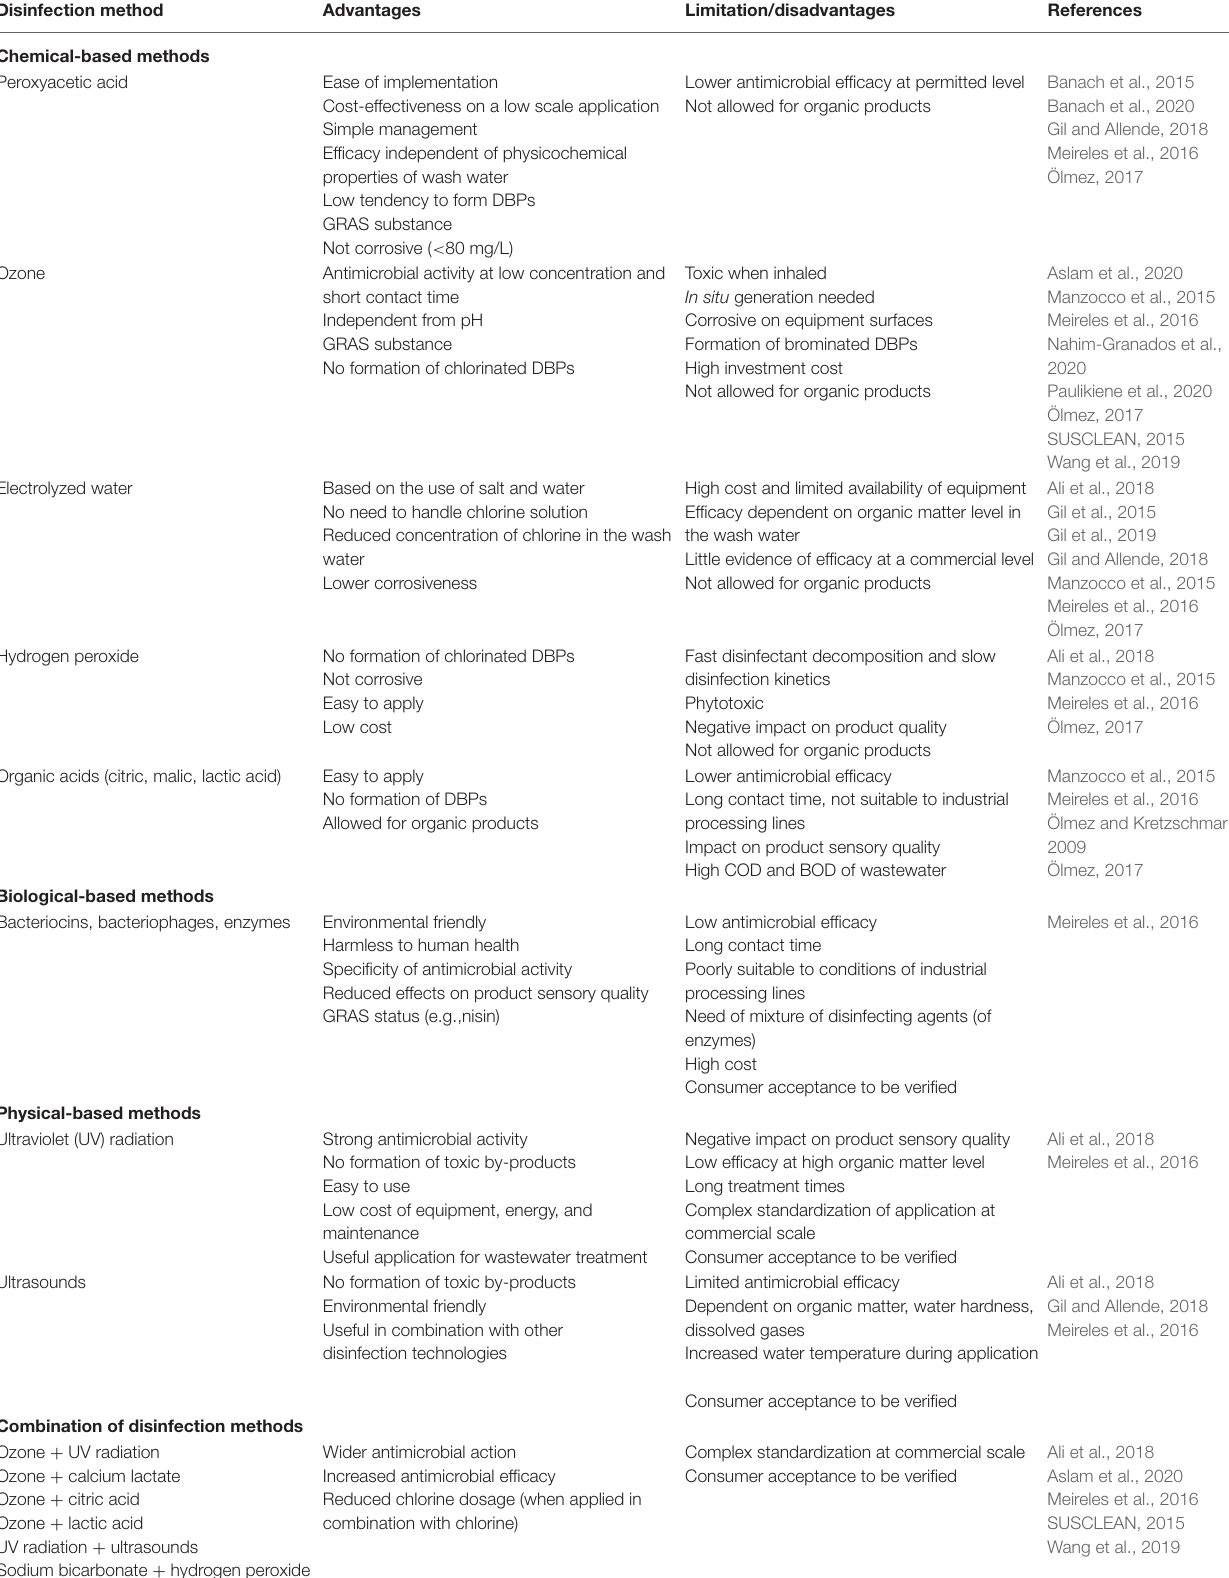
TABLE 2 | Advantages and limitations of alternative disinfection methods proposed to replace the use of